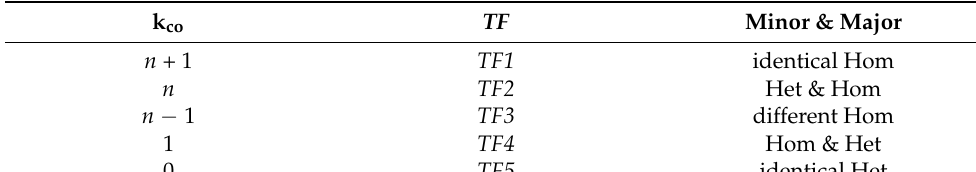
where TF denotes the theoretical F MAR values of A-SNP. The variable n indicates the mixture ratio 1: n , and it can be any number greater than or equal to 1, including decimals. Three of the coefficient “k co ” of Equation (1) are determined by the variable n . When the Table 2. Relationship among k co , TF , and the genotype combinations mixture ratio is fixed (i.e., n is unique), the relationship between k co , TF , and the genotype combinations is shown in Table 2. If n = 1 (at the ratio of 1:1), then from Equation (1),